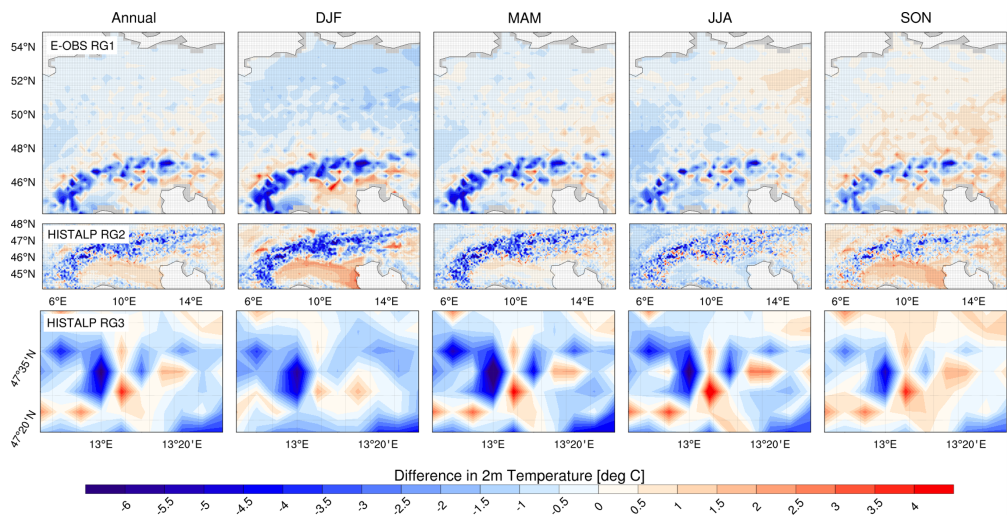
Figure 2. Annual and seasonal temperature difference for the reanalysis simulation 1980–2009 compared to E-OBS data in RG1 (top row), and to HISTALP in RG2 (center row) and RG3 (bottom row), respectively.